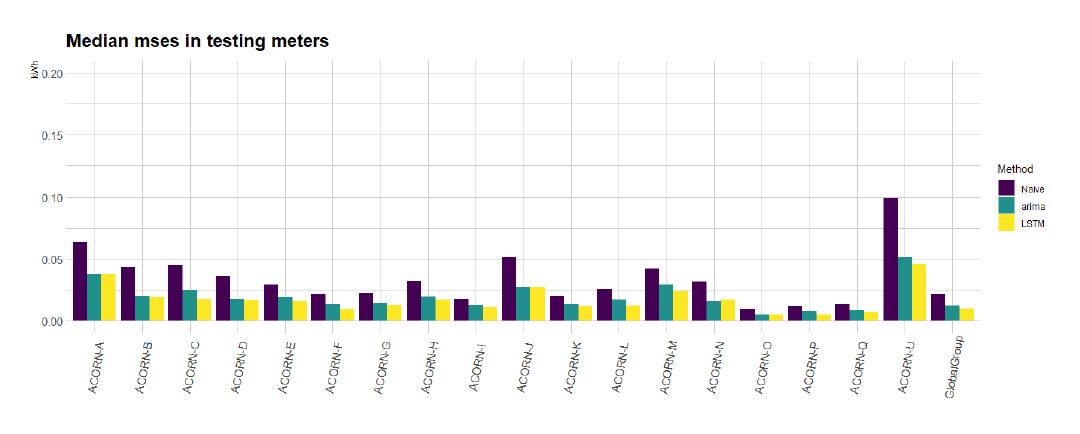
Figure 13. Out-of-sample performance for smart meters in the testing set.